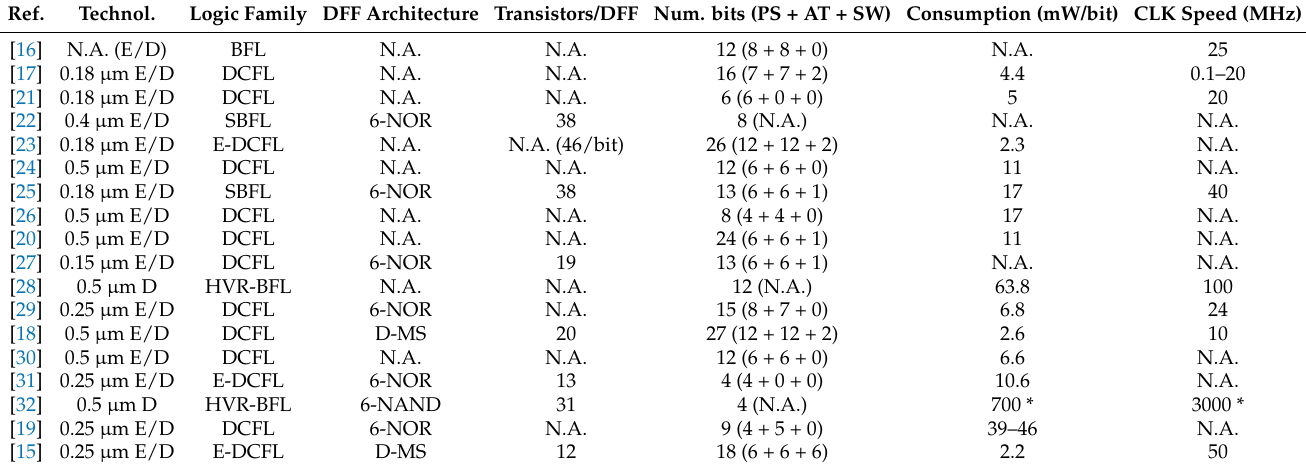
Table 1. State of the art of GaAs-based SIPO interfaces for CC applications.